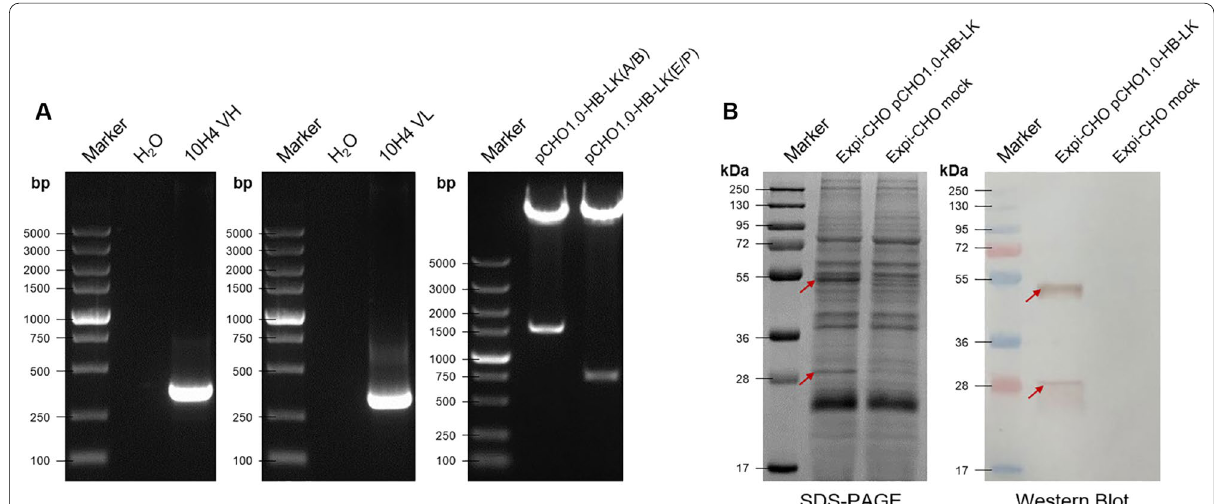
Fig. 3 Chimeric plasmid construction and the expressed antibody identification. A PCR amplification of the MAb, VH (variable region of heavy chain), VL (variable region of light chain); B Restriction digestion of pCHO1.0-HB-Lκ, A/B ( Avr II and BstZ 17I), E/P ( Eco R V and Pac I); C SDS-PAGE and